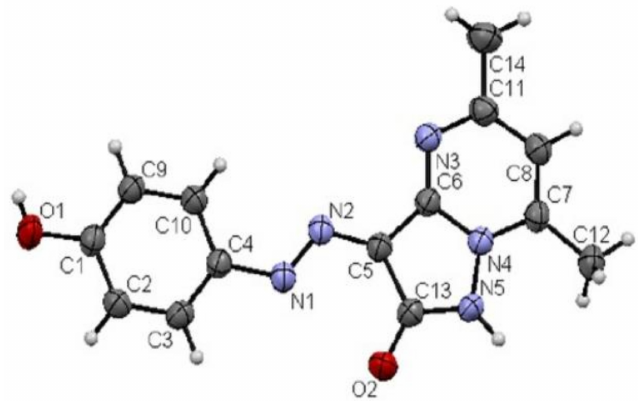
Figure 4. ORTEP of dye 9 .